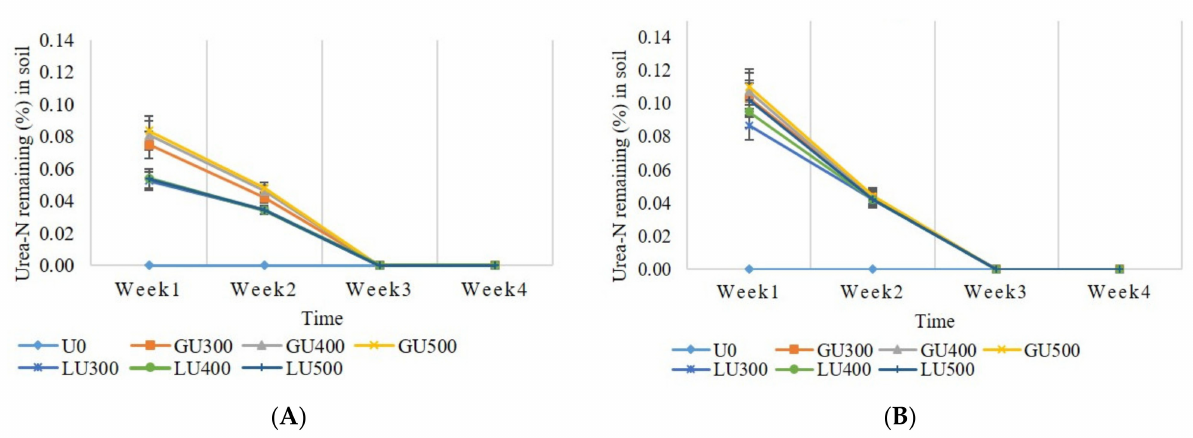
Figure 3. Urea-N remaining (%) in Bungor ( A ) and Selangor ( B ) soils treated with different rate of LU and GU fertilizers during the four weeks of incubation. Vertical bars on the graphs show the standard